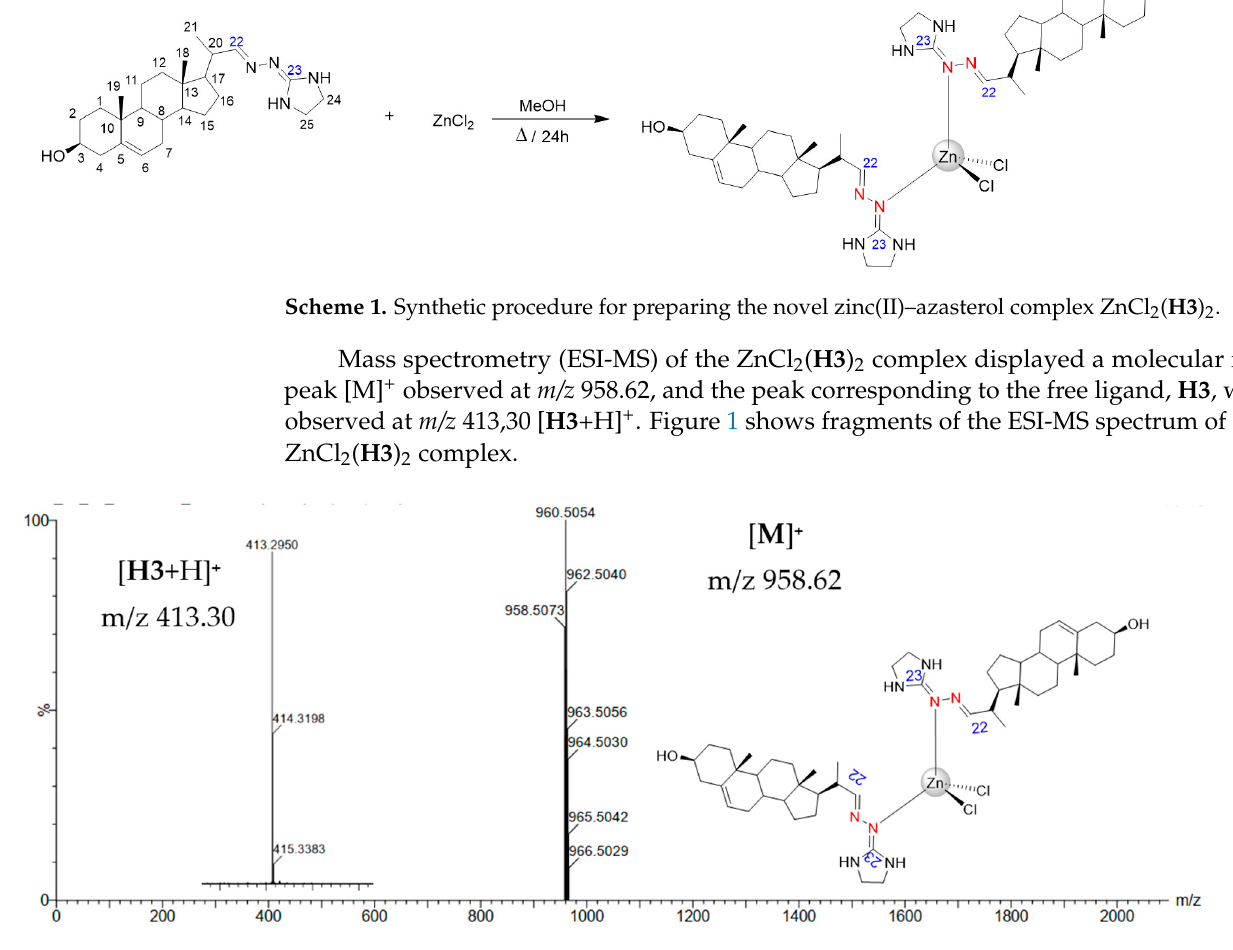
Figure 1. ESI-MS spectrum fragments of ZnCl 2 ( H3 ) 2 .